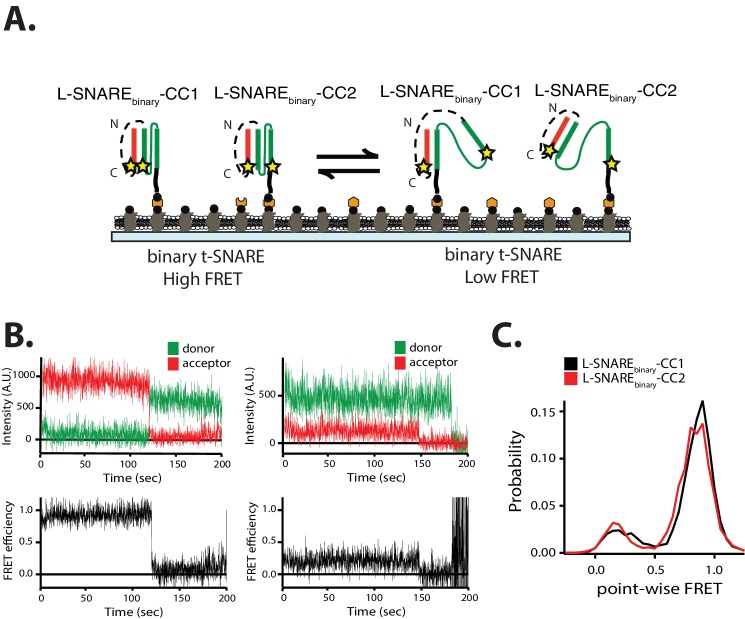
Configurations of isolated linked binary t-SNARE complexes.(A) Schematic of configurations of the linked binary t-SNARE complexes, L-SNAREbinary-CC1 and L-SNAREbinary-CC2, with labels (indicated by stars) at residue 249 of syntaxin-1A and residue 76 or residue 197 of SNAP-25A, respectively. (B) Representative single-molecule fluorescence intensity time traces of L-SNAREbinary-CC1 in the absence of disassembly factors (top panels). The fluorescence intensities were converted to FRET efficiency time traces (bottom panels). (C) Corresponding point-wise FRET efficiency histograms using all observed traces.